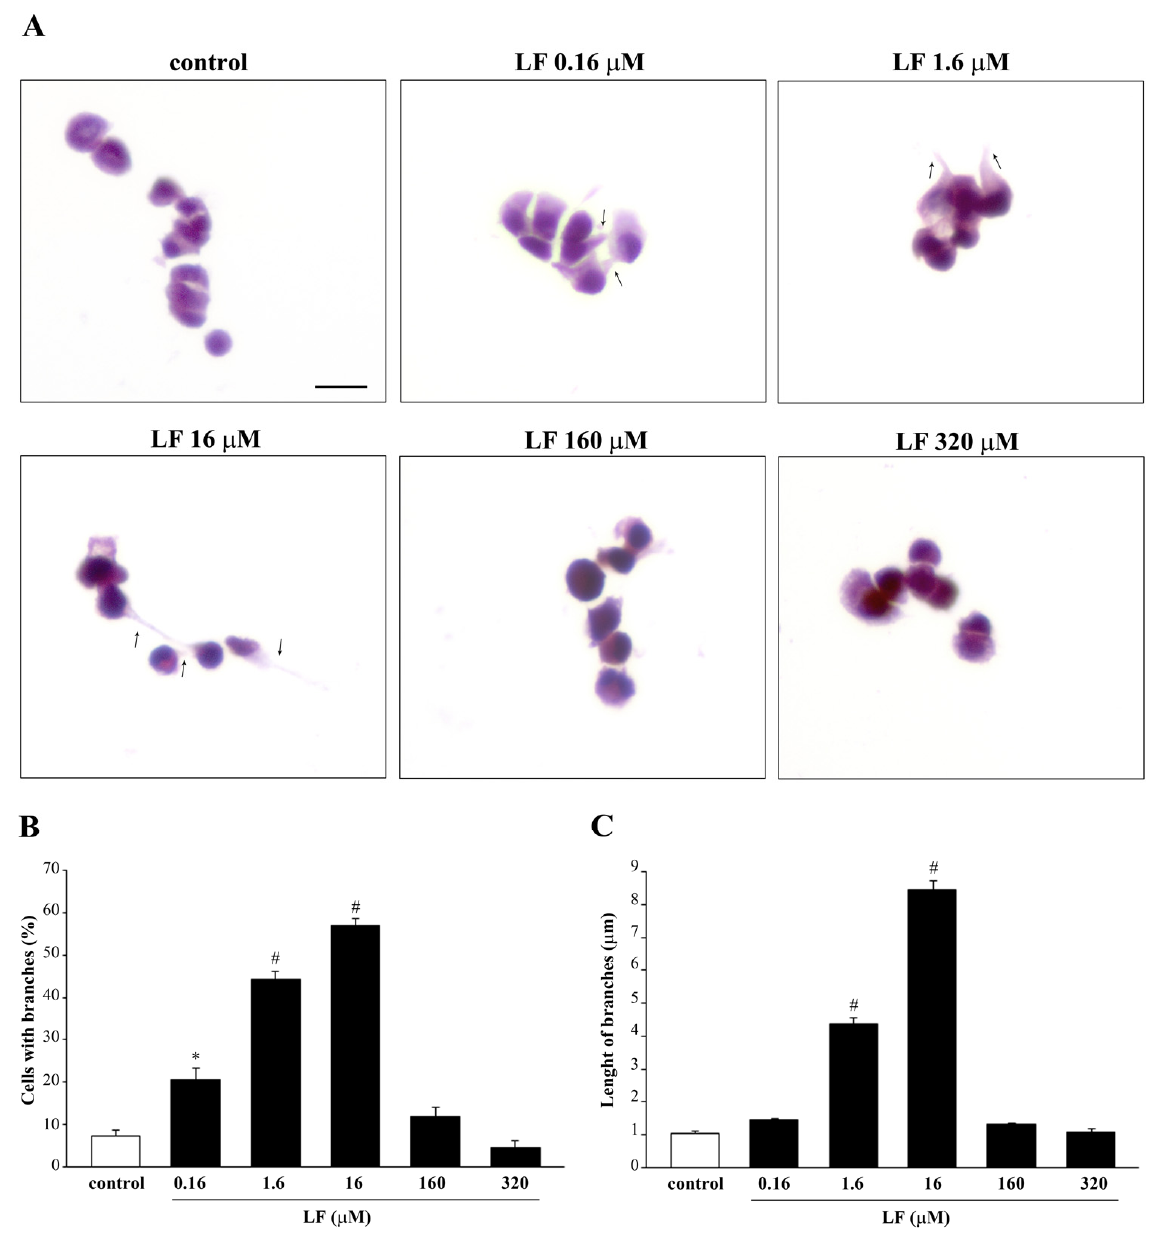
Figure 3. Morphological changes induced by LF in PC12 cells. ( A ) Representative pictures of H&E-stained PC12 cells after treatment with LF ranging from 0.16 µ M up to 320 µ M for 72 h. Cell branches (arrows) are induced by LF. The histograms report ( B ) the mean number of cells with branches and ( C ) the mean branch length for each dose of LF. * p < 0.05 compared with control; # p < 0.05 compared with other groups. Scale bar = 15 μ M.